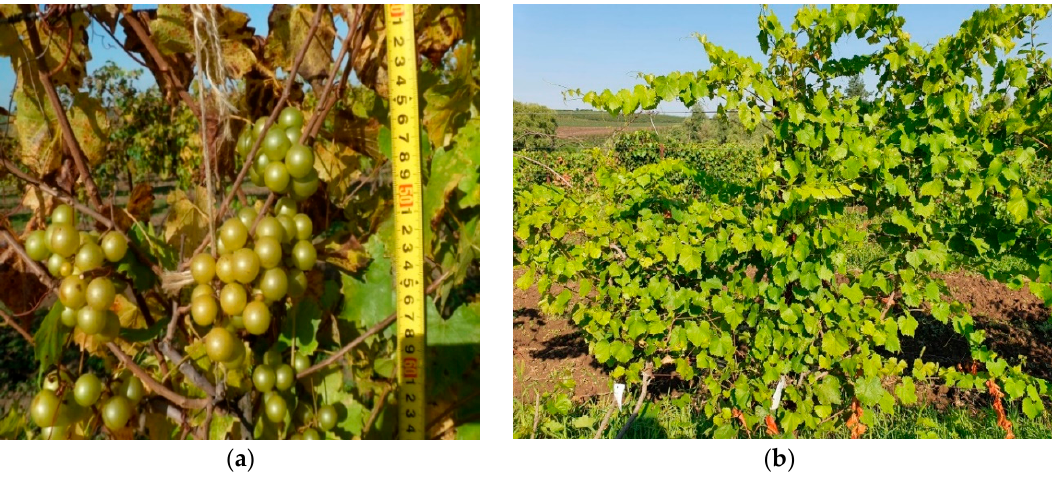
Figure 1. Muscadinia rotundifolia cv. Dixie at the experimental vineyard of the Krymsk Experimental Station of VIR (the southwestern part of the North Caucasus) (photo by V.A. Nosulchak): ( a ) fruiting in 2021; ( b ) plant habit of a twenty-year-old S1 progeny produced from selfing of ‘Dixie’ plant.